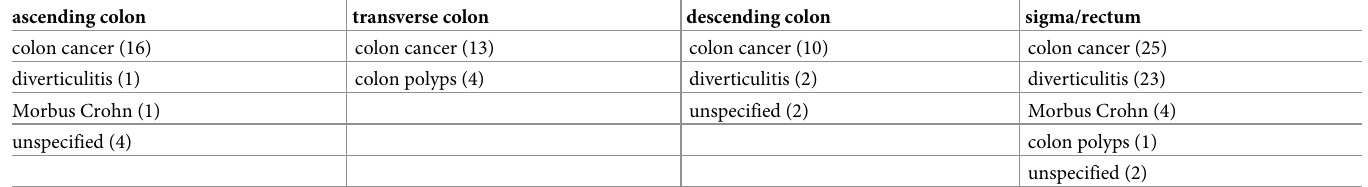
Table 1. Location of human colonic specimens and diseases underlying the